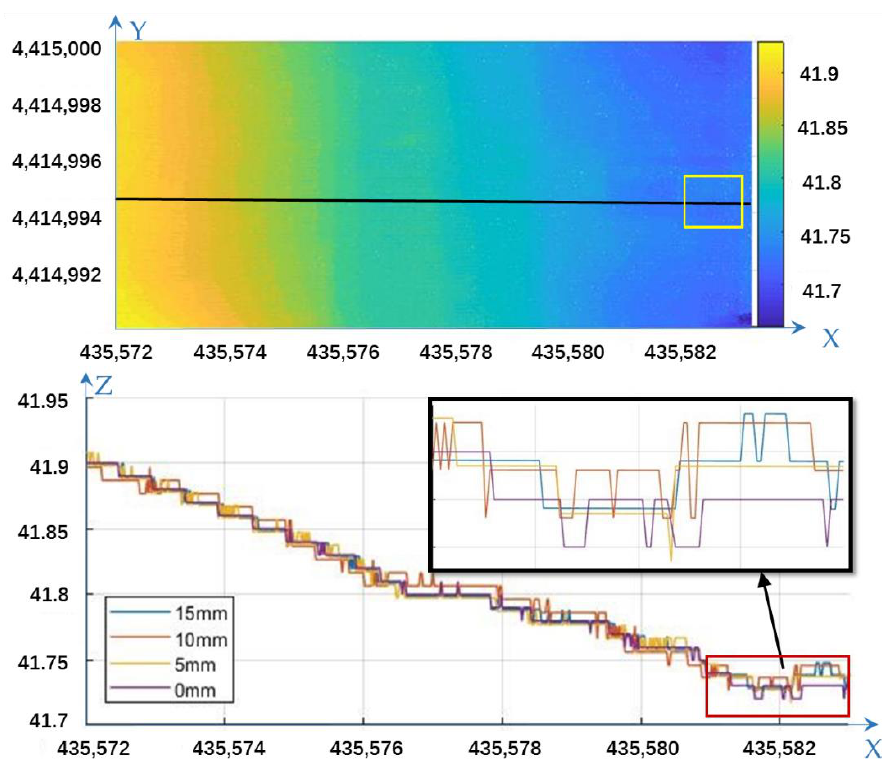
Figure 15. The profiles for all sets of interpolation results (m).